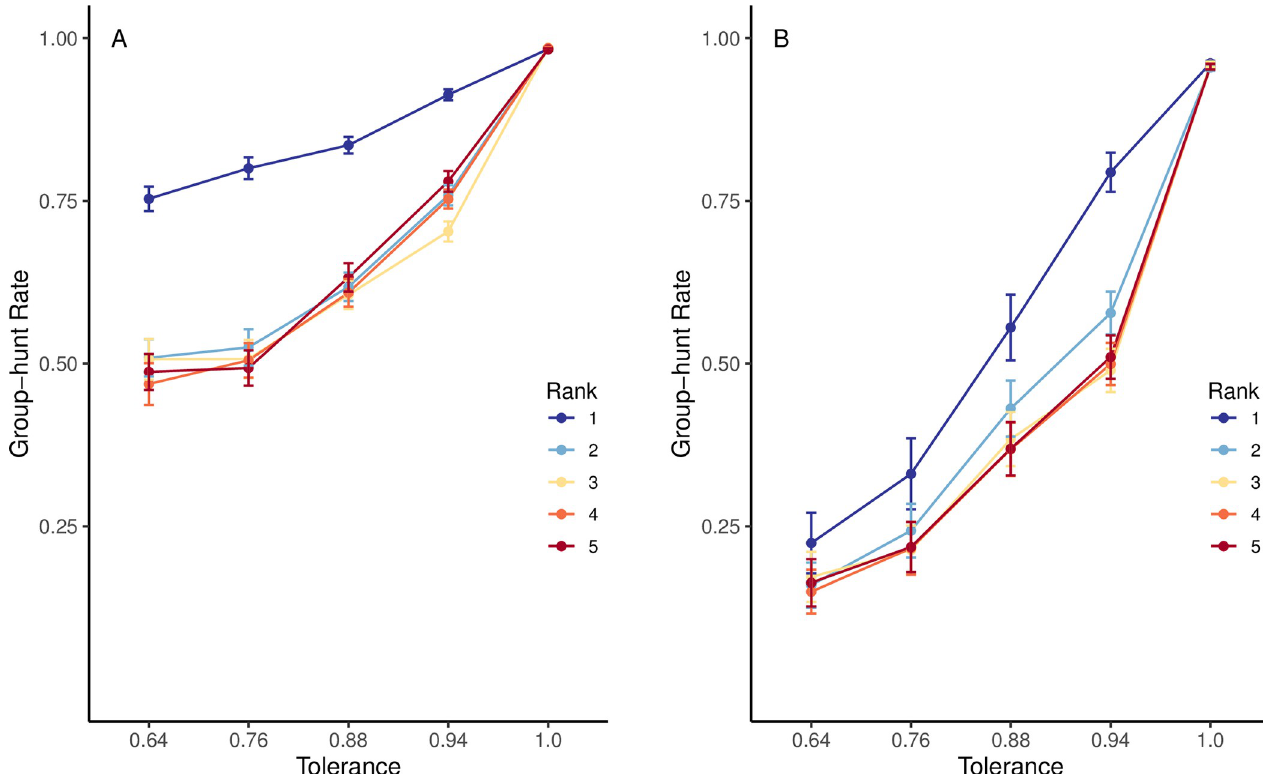
Fig 3. Group-hunting rates under varying tolerance conditions. The average rate of group hunting in the agent population across different tolerance levels when the group-hunting payoff is (A): 2 times the solo-hunt payoff per capita and (B): 1.2 times the solo-hunt payoff per capita. Tolerance determined how equally the reward from group hunting was shared (i.e., 1 = shared equally, 0.64 = each agent gets 64% of the reward as the agent with the rank immediately above it). Each point represents the average group-hunting rate of the agents in their respective relative rank positions within hunting subgroups (e.g., rank 1 = highest ranking agent in the subgroup). Each tolerance condition was run for 1,000,000 updates (sampled every 1,000 updates), plots represent the mean of the last 100,000 updates (n = 101 samples) averaged across 200 replicates per condition. Bars represent ± 2 standard errors of the mean group-hunting rates among agents of each relative rank across each tolerance